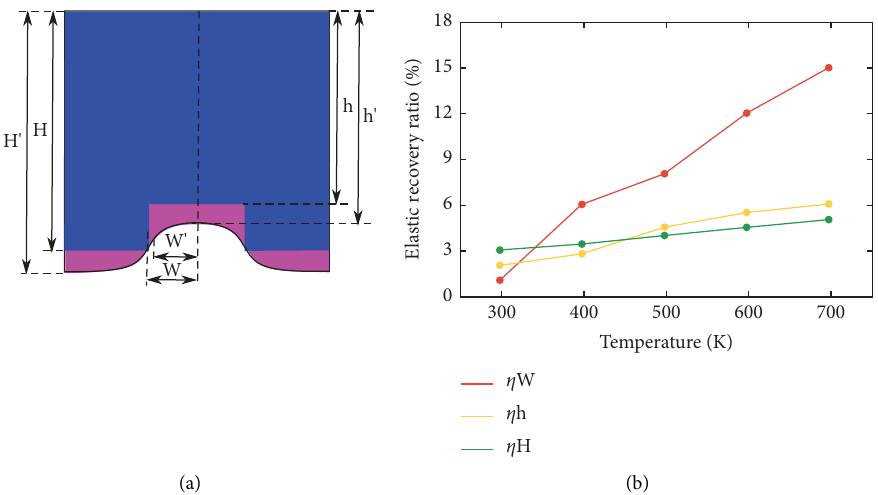
Figure 5: (a) Illustration of parameters defning the elastic recovery and (b) elastic recovery as a function of imprinting temperature for the tip-like pattern.